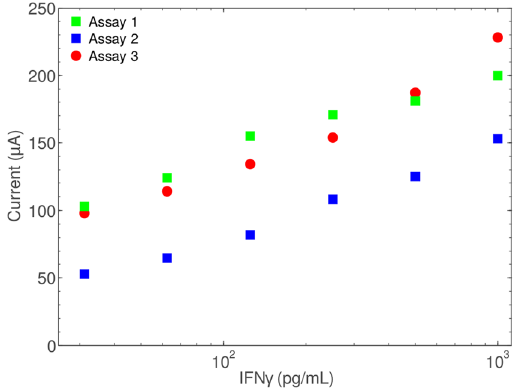
Figure 6. Three discrete IFN γ titration assays were performed in a plasma matrix. TMB reporter solutions harvested from each were applied to a different sensor to produce the three measurement series. Therefore, this analysis demonstrates the additive variabilities from assay steps, electrochemistry, and between sensor measurements.